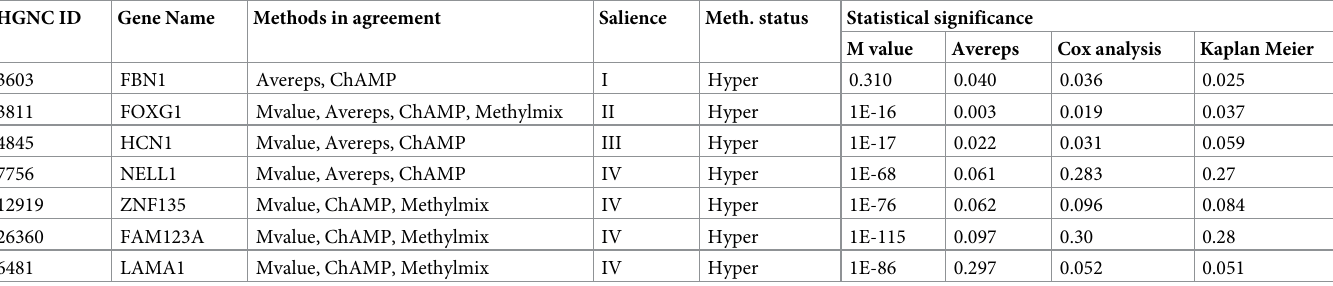
Table 5. Stage-salient biomarkers.